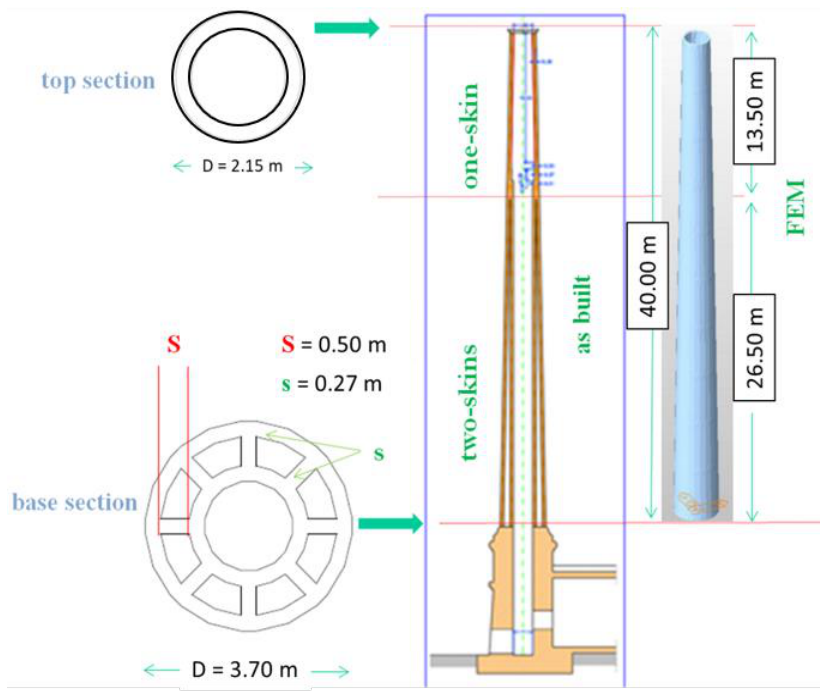
Figure 5. The historical masonry chimney under